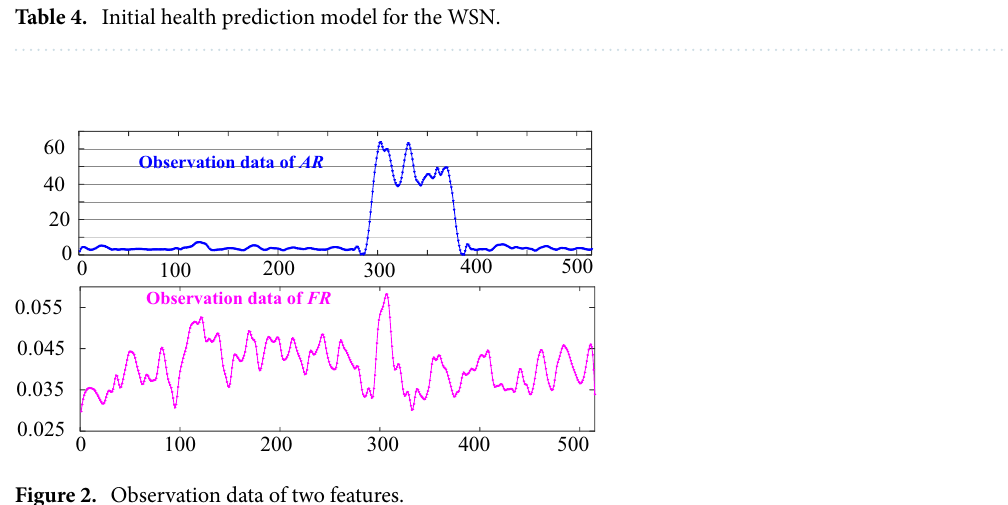
Figure 2. Observation data of two